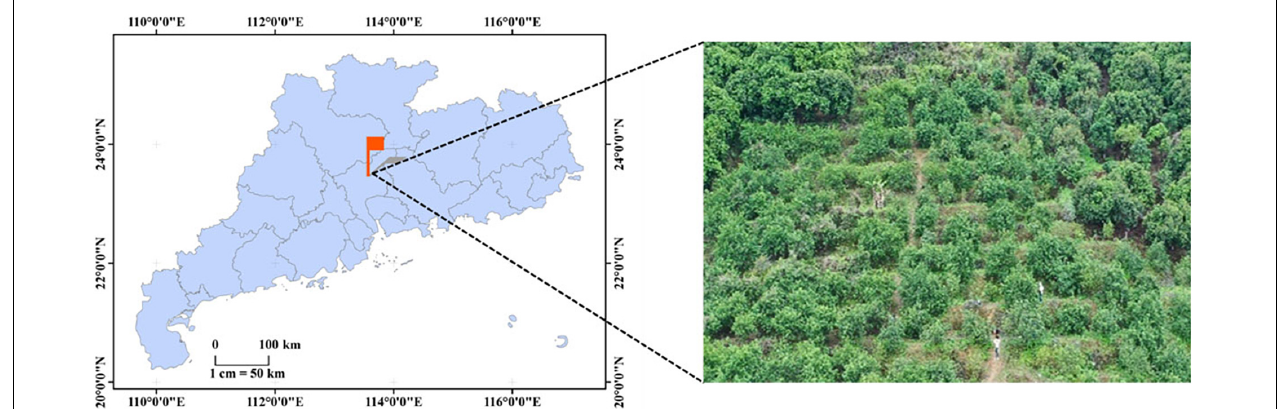
FIGURE 1 | Location of images acquisition